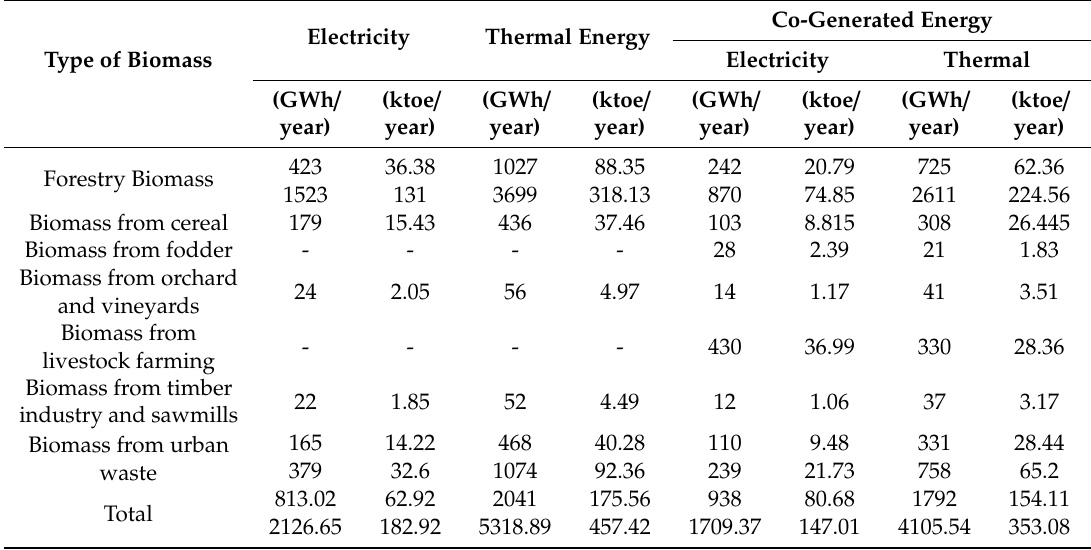
Table 8. Annual amount of electricity, thermal energy, and co-generation from biomass